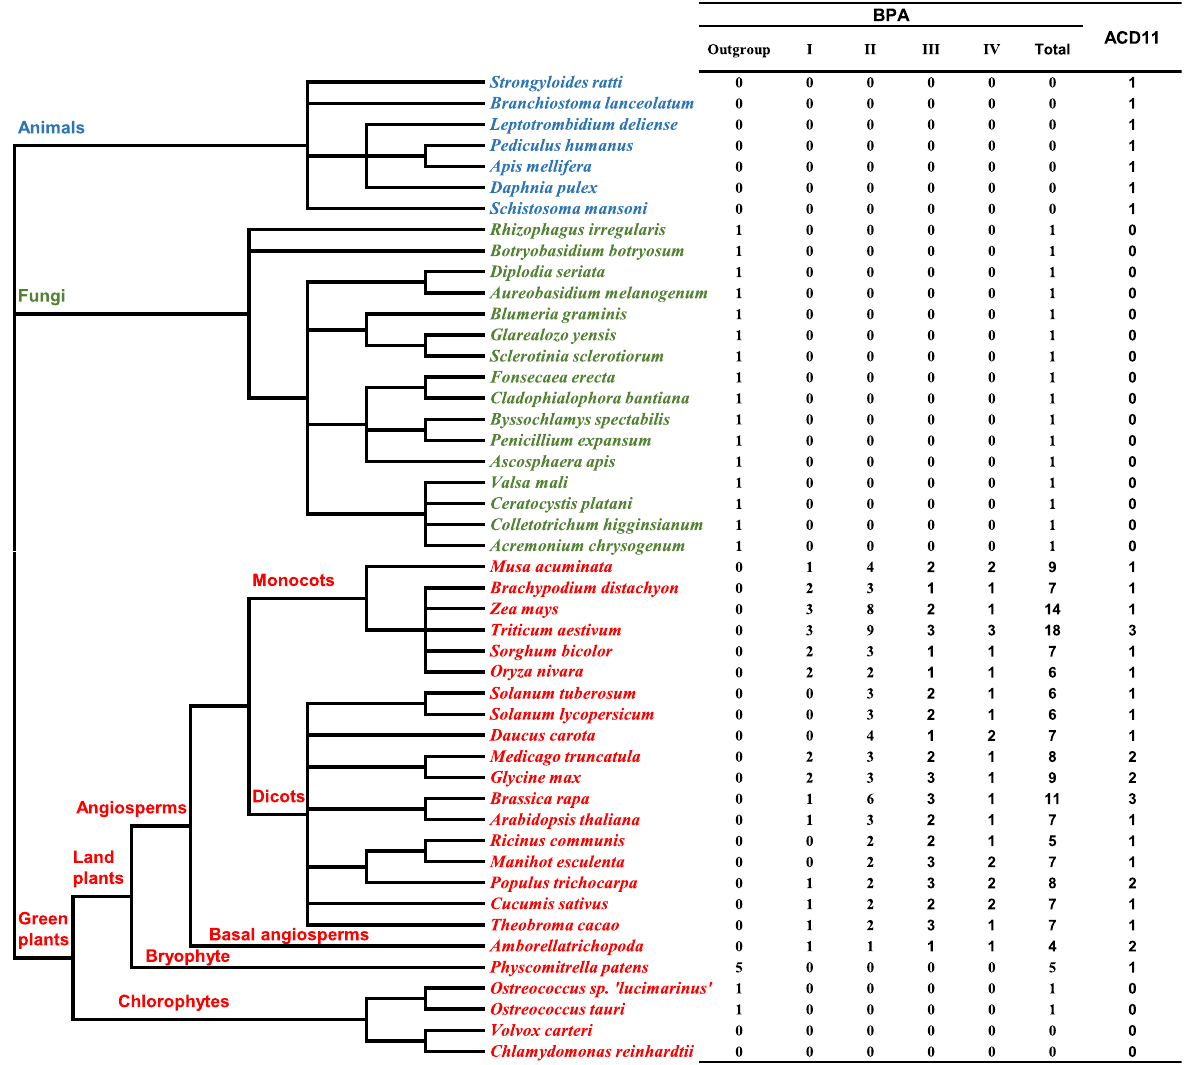
Fig. 2 The schematic of species phylogenetic relationships and distribution of BPA and ACD11 homologous genes in different species. The species tree was generated using the NCBI Taxonomy tool. Classified and total numbers of BPA and ACD11 homologs identified in each species were